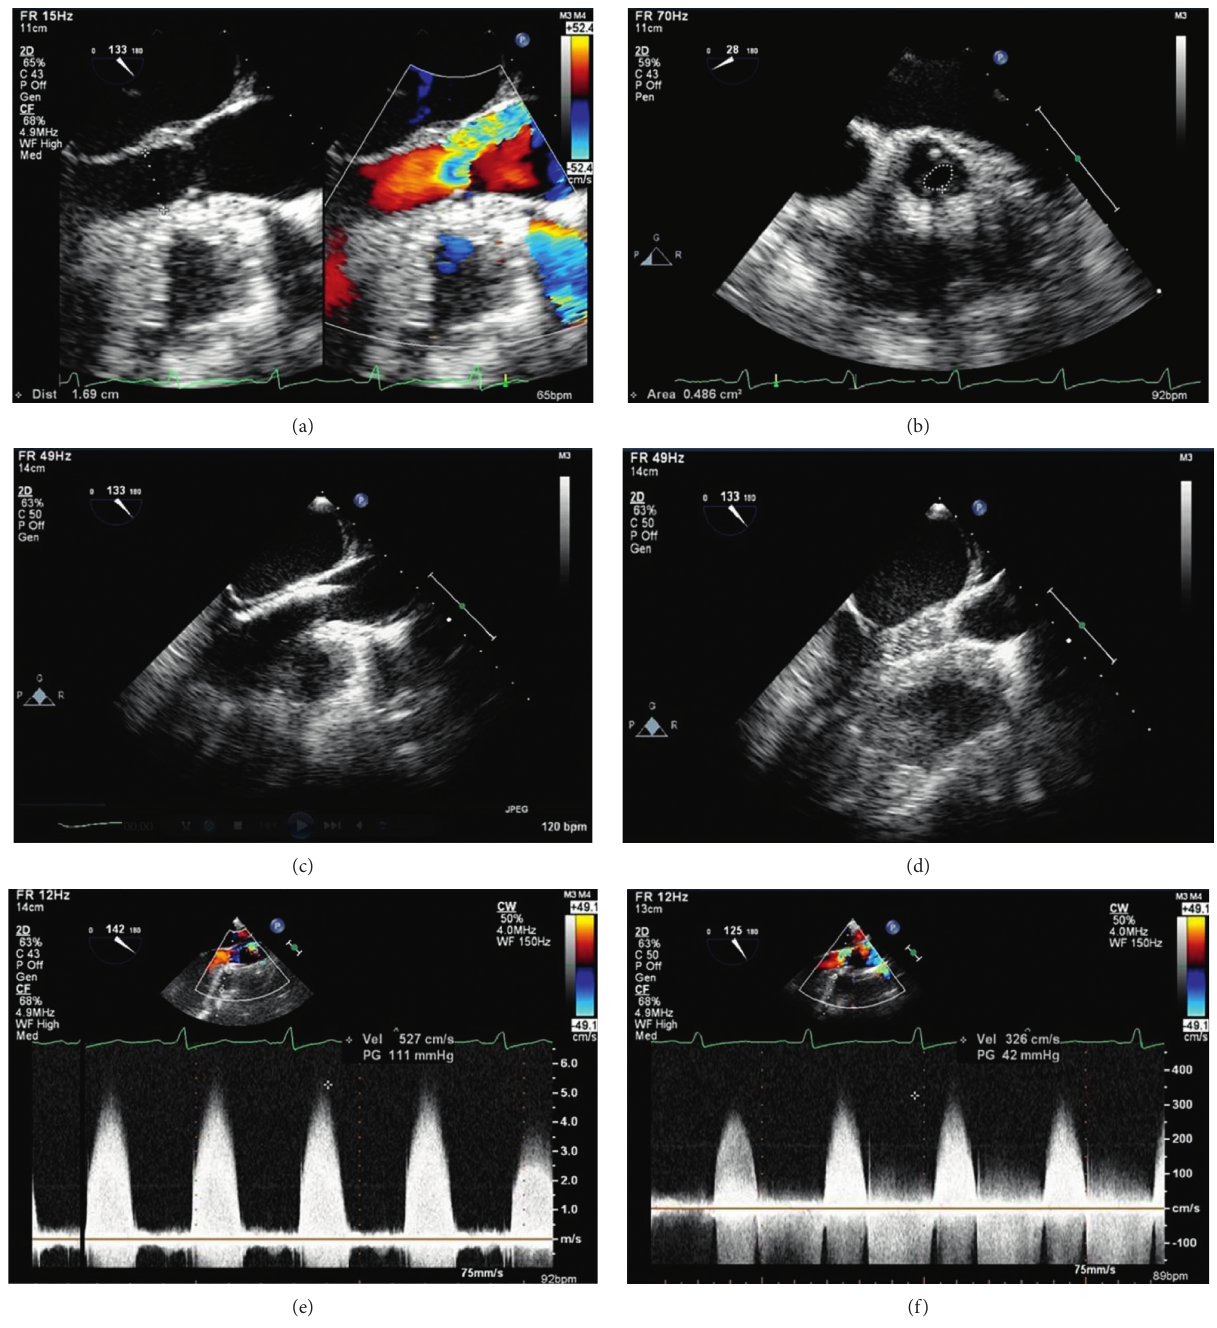
Figure 1: Representative images obtained from a patient during transthoracic ultrasound-guided percutaneous balloon aortic valvuloplasty. (a) Preoperative measurement of the aortic annulus (1.69cm). (b) Preoperative measurement of the aortic valve area (0.48 cm 2 ). (c) Intraoperative echocardiography showed that the guide-wire had passed through the stenotic aortic valve. (d) Intraoperative echo- cardiography showed that the balloon had passed through the stenotic aortic valve and the balloon had filled to expand the aortic valve. (e) The preoperative aortic valve flow rate was 5.3 m/s, and severe stenosis was evident. (f) Postoperatively, the aortic valve flow rate had decreased to 3.2m/s and the aortic stenosis was significantly